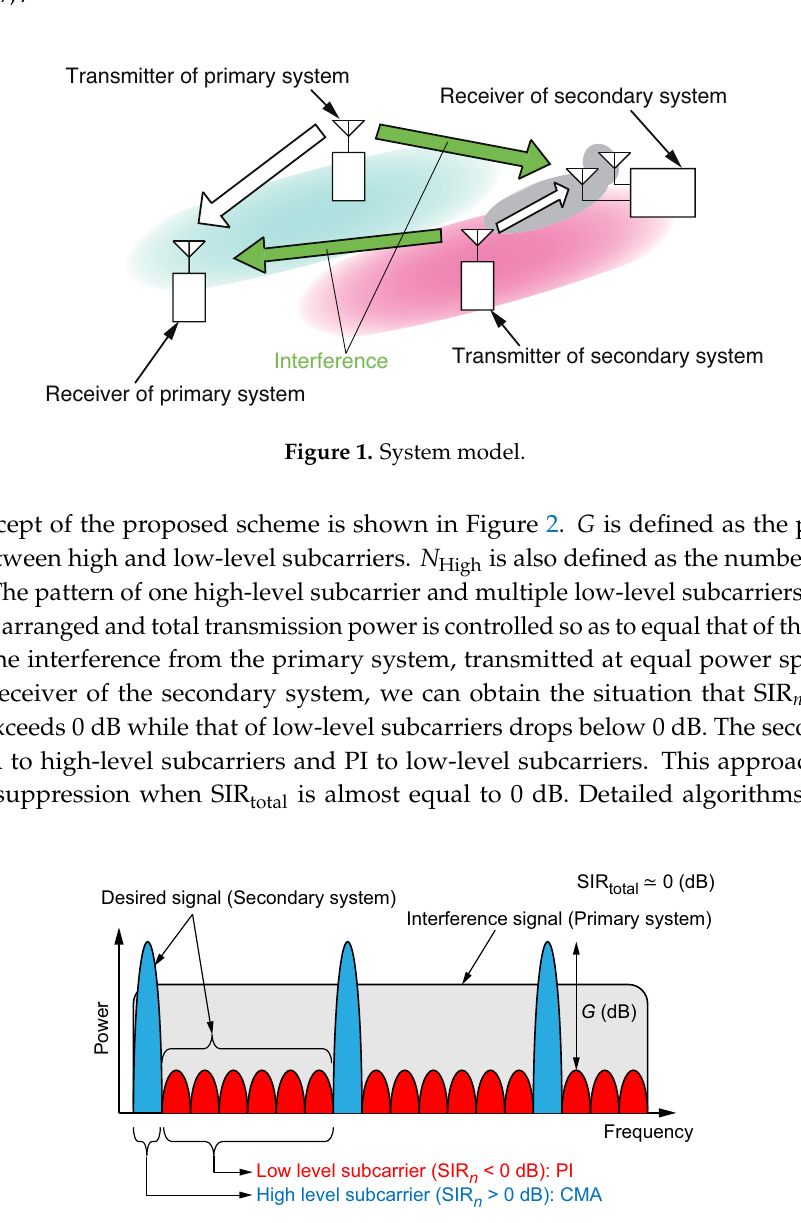
Figure 2. Concept of blind adaptive array with subcarrier transmission power assignment